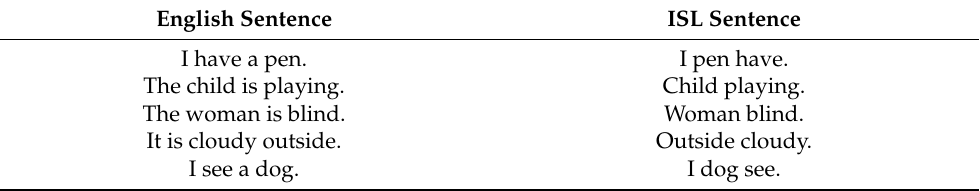
Table 3. English sentence–ISL sentence